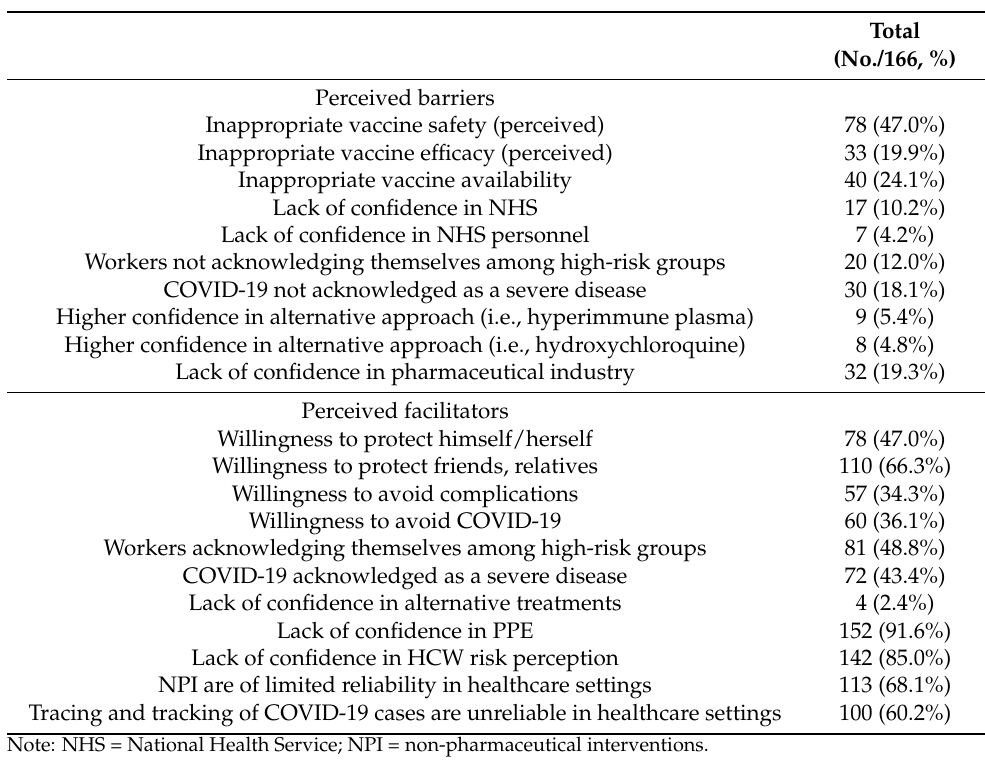
Table 4. Perceived barriers and facilitators towards SARS-CoV-2 vaccination in occupational settings as reported by 166 occupational physicians participating in the survey (January